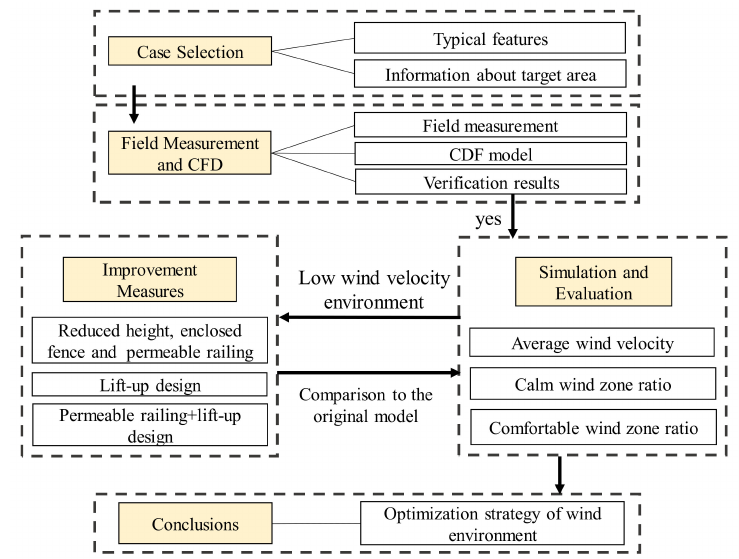
Figure 1. Framework and workflow of this